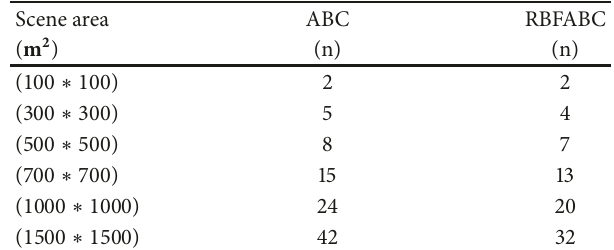
Table 1: Optimization results of the two algorithms in certain